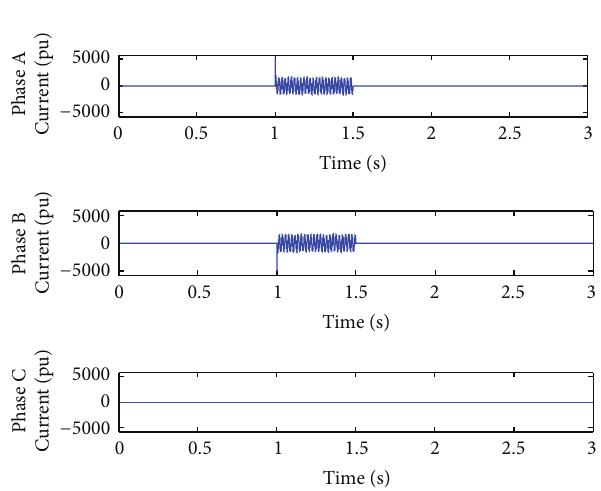
Figure 12: Load voltage during L-L fault.